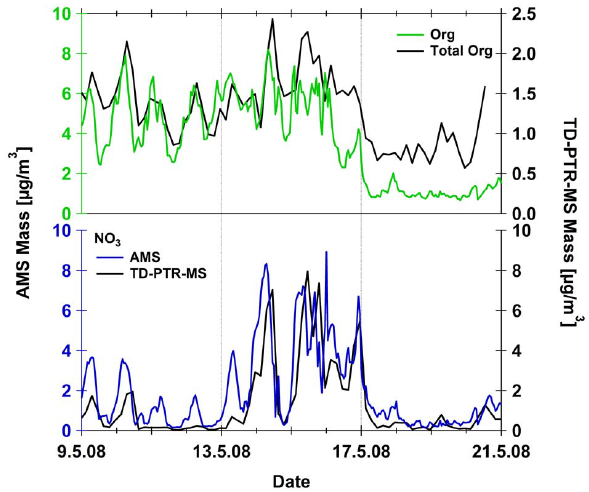
Fig. 6. Comparison of AMS to TD-PTR-MS results. Lower panel: Figure 6: Comparison of AMS to TD-PTR-MS results. Lower panel: AMS nitrate (blue, left 3 AMS nitrate (blue, left axis) and TD-PTR-MS nitrate ( m/z 46, black, axis) and TD-PTR-MS nitrate ( m / z 46, black, right axis). Upper panel: AMS organic (green, 4 right axis). Upper panel: AMS organic (green, left axis) and TD- left axis) and TD-PTR-MS total organic (black, right axis). 5 PTR-MS total organic (black, right